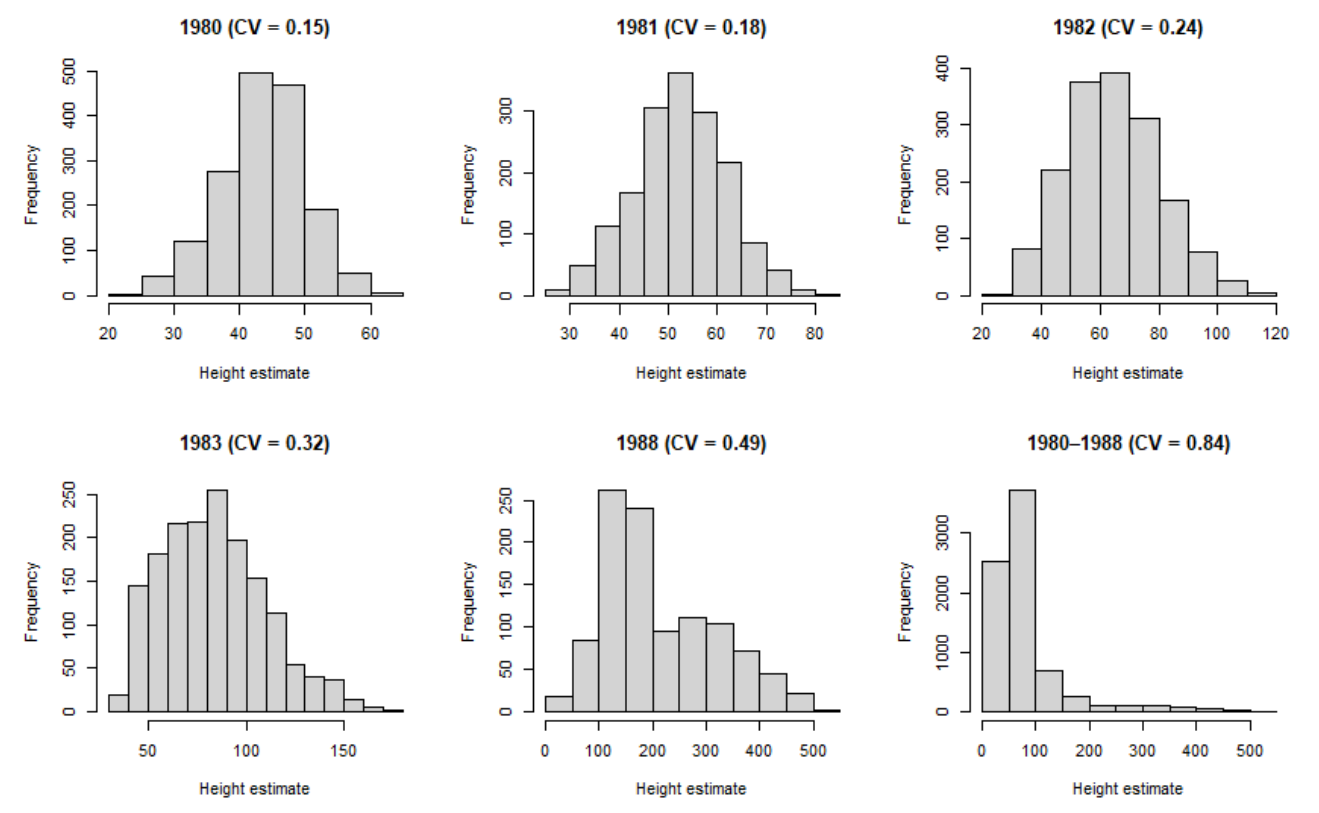
Figure 3. Histograms of tree height estimates within and across years (1980–1983, 1988), with coefficients of variation (CV) displayed above each histogram.